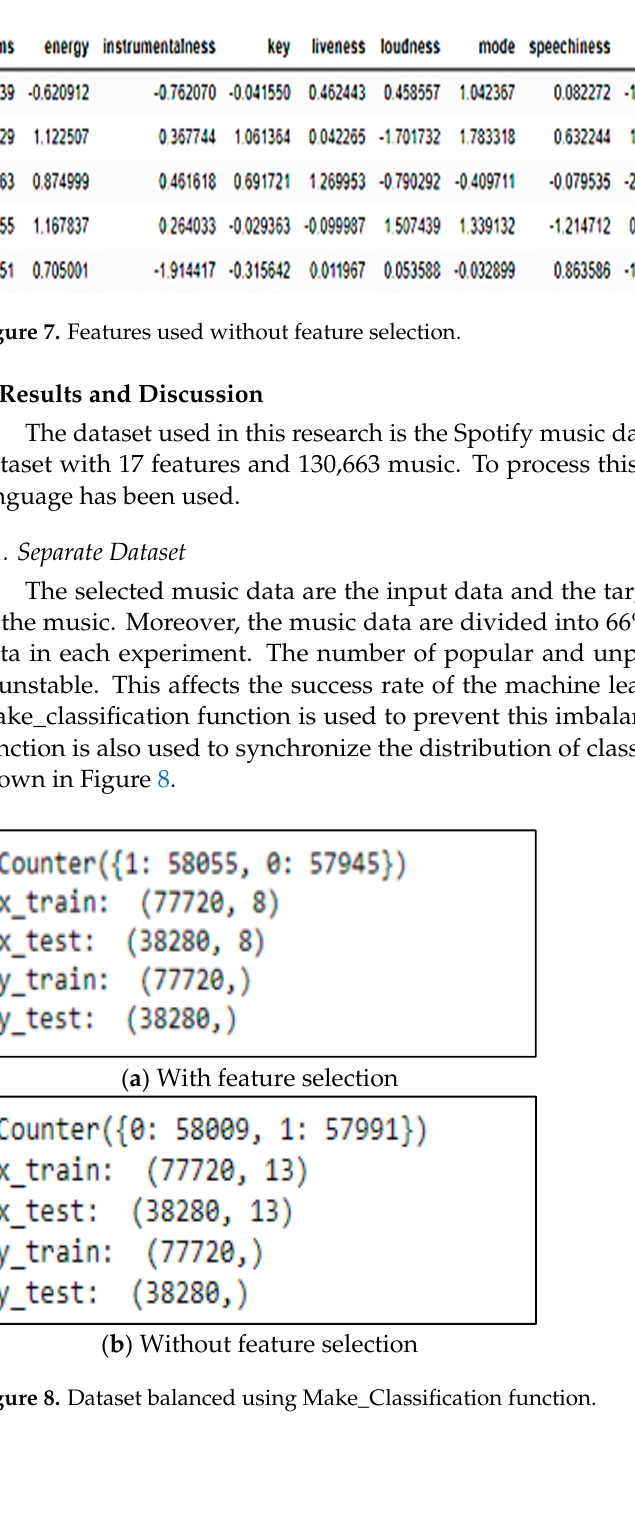
Figure 6. Features selected by feature selection.